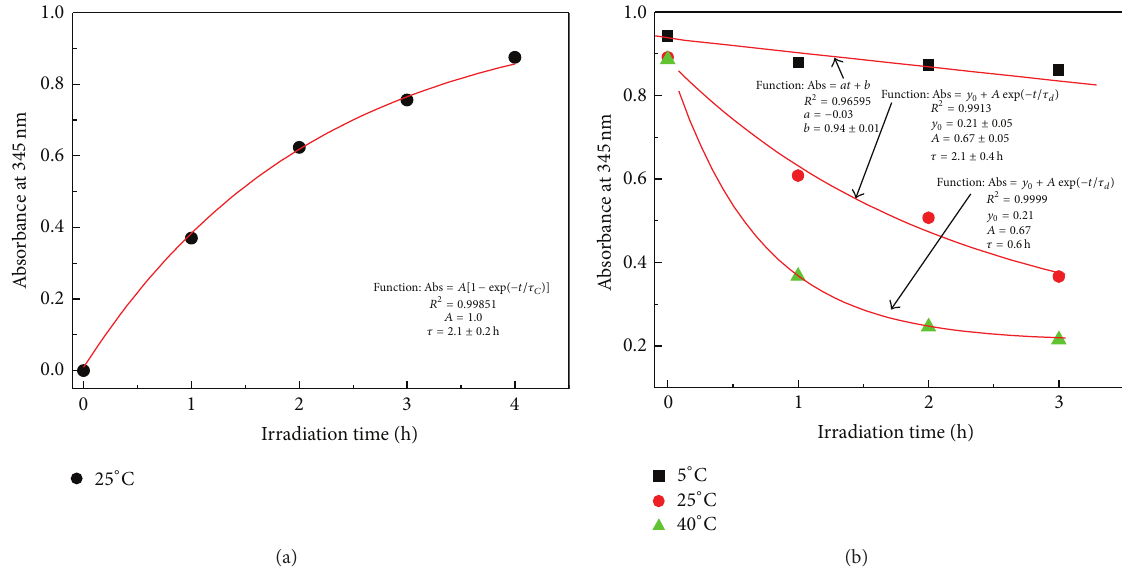
Figure 7: (a) Growth kinetics regime of photoproducts formation for 25 ∘ C fitted by an exponential growth function. (b) Decay kinetics regime for 5, 25, and 40 ∘ C fitted by an exponential decay